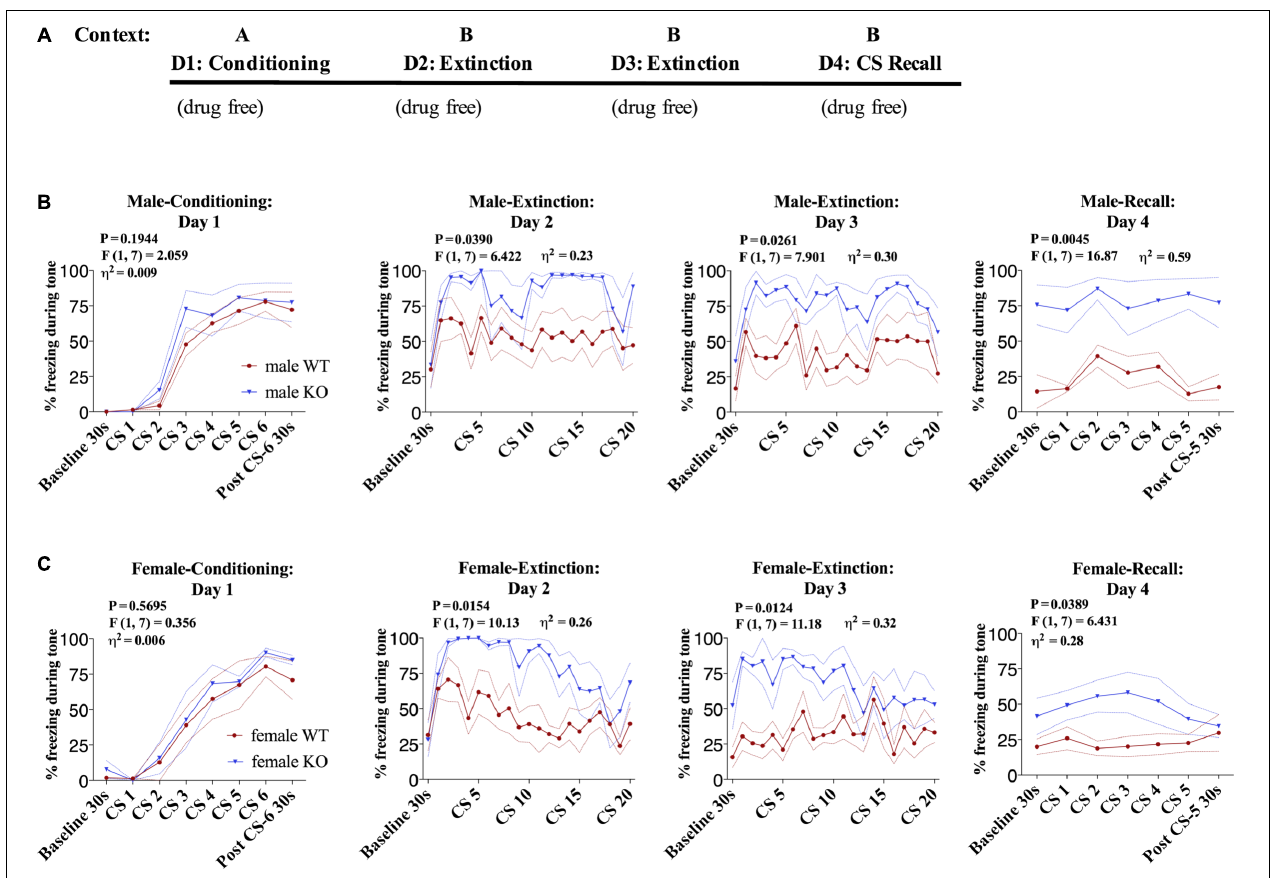
FIGURE 1 | Male and female DAGL α − / − mice have impaired fear extinction. (A) Schematic diagram of the experimental paradigm. (B) (Far left panel) % freezing by male DAGL α − / − and WT mice during acquisition of cue-conditioned fear. (Middle panels) % freezing during auditory cue during extinction training days 2 and 3. (Far right panel) % freezing during extinction recall ( n = 5 WT, n = 4 KO mice). (C) (Far left panel) % freezing by female DAGL α − / − and WT mice during acquisition of cue-conditioned fear. (Middle panels) % freezing during auditory cue during extinction training days 2 and 3. (Far right panel) % freezing during extinction recall ( n = 5 WT, n = 4 KO mice). F - and P -values and η 2 for genotype effect shown in each panel. All values are presented as mean ±